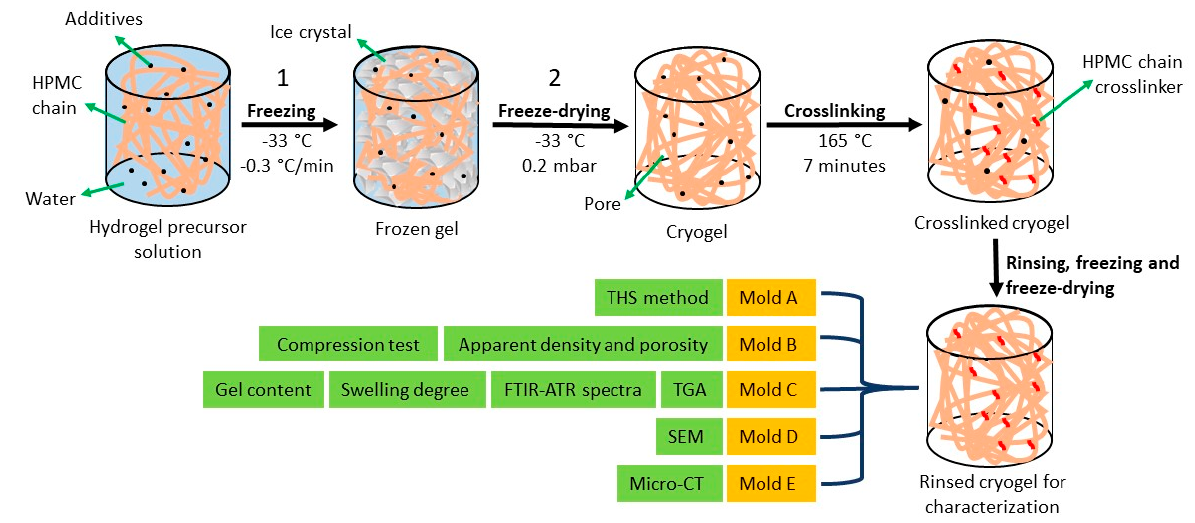
Figure 12. Experimental procedure for the cryogel preparation and characterization. The samples were molded in five different molds (A–E) of different sizes and shapes. Each type of analysis required samples prepared with a specific mold due to the size of rgw sample holder or the intrinsic measurement condition. The additives represent Kolliphor ® EL, AOT, citric acid, and sodium hypophosphite.